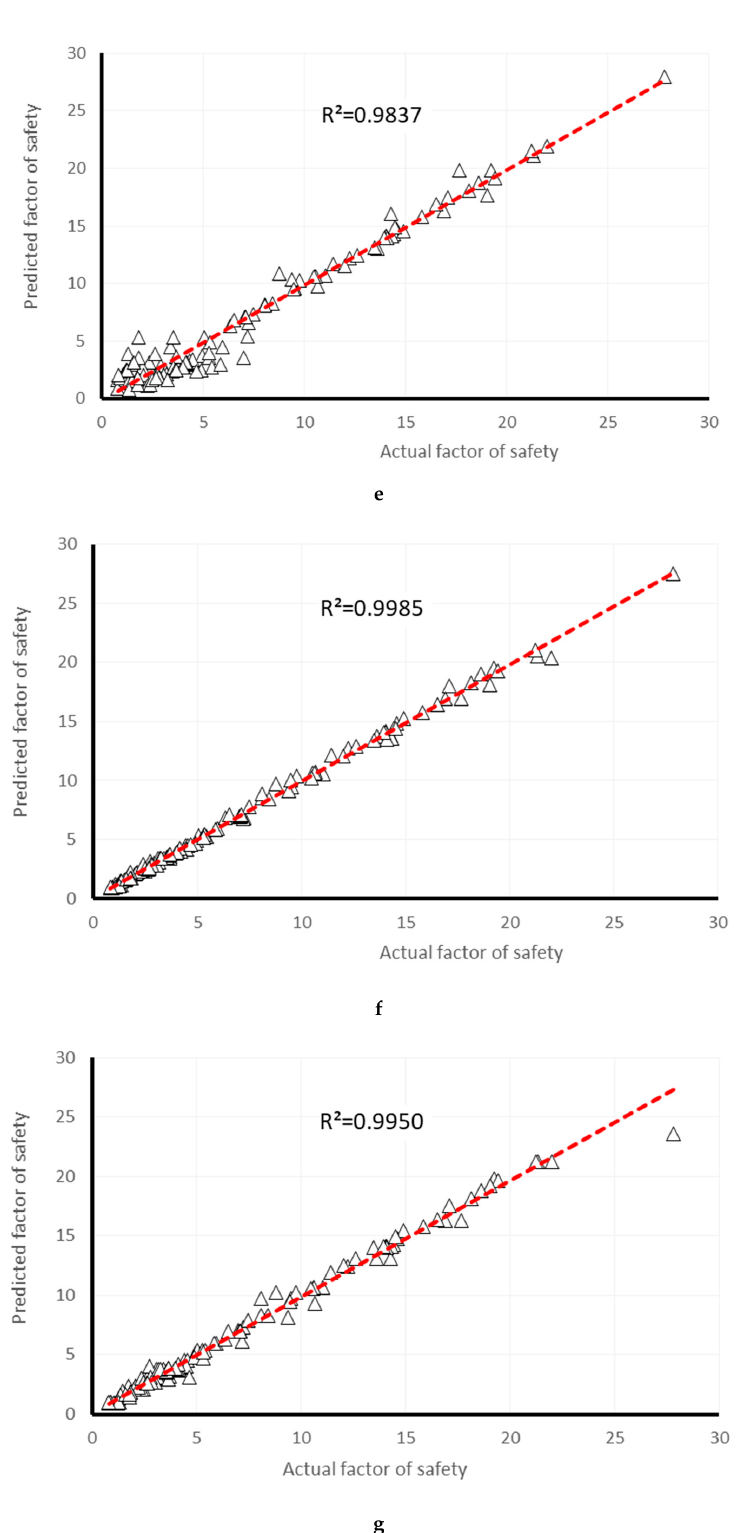
Figure 9. The network result for the testing dataset in ( a ) multiple linear regression (MLR), ( b ) multi-layer perceptron (MLP), ( c ) radial basis function regression (RBFR), ( d ) improved support vector machine using sequential minimal optimization algorithm (SMO-SVM), ( e ) lazy k-nearest neighbor (IBK), ( f ) random forest (RF), and ( g ) random tree